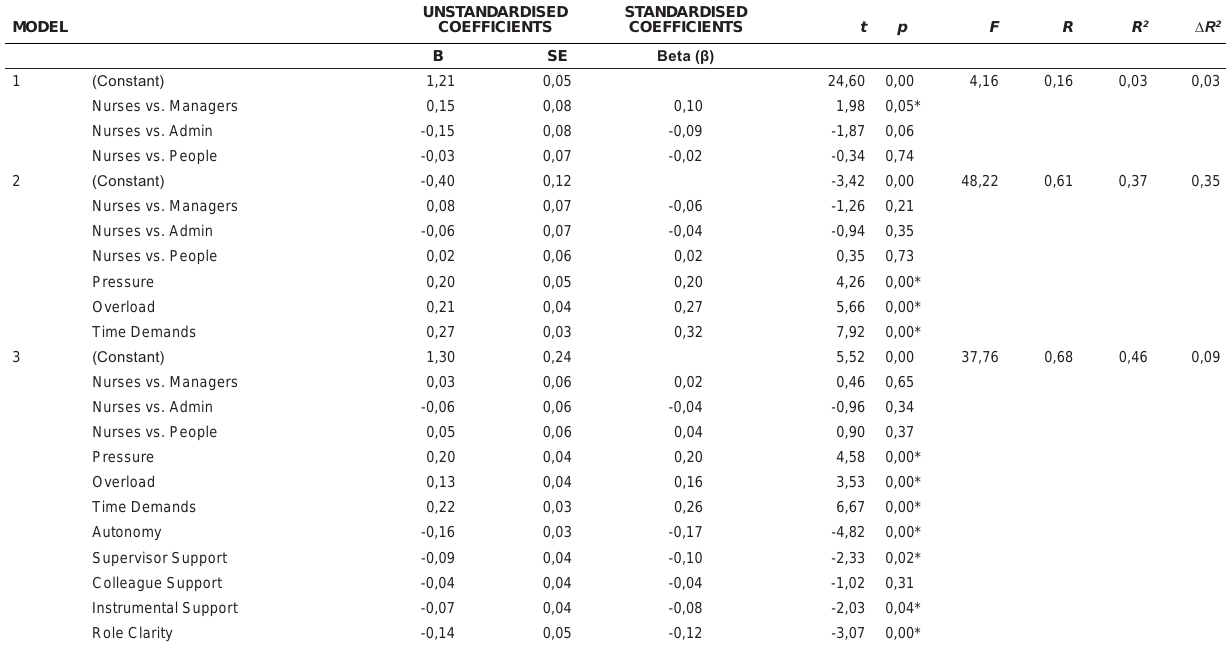
taBLe 4 Multiple regression analyses with negative WHI as dependent variable